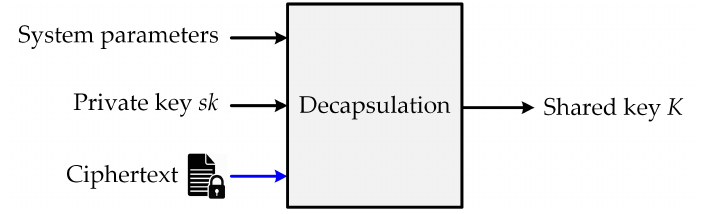
Figure 5. Decapsulation process of a key-establishment